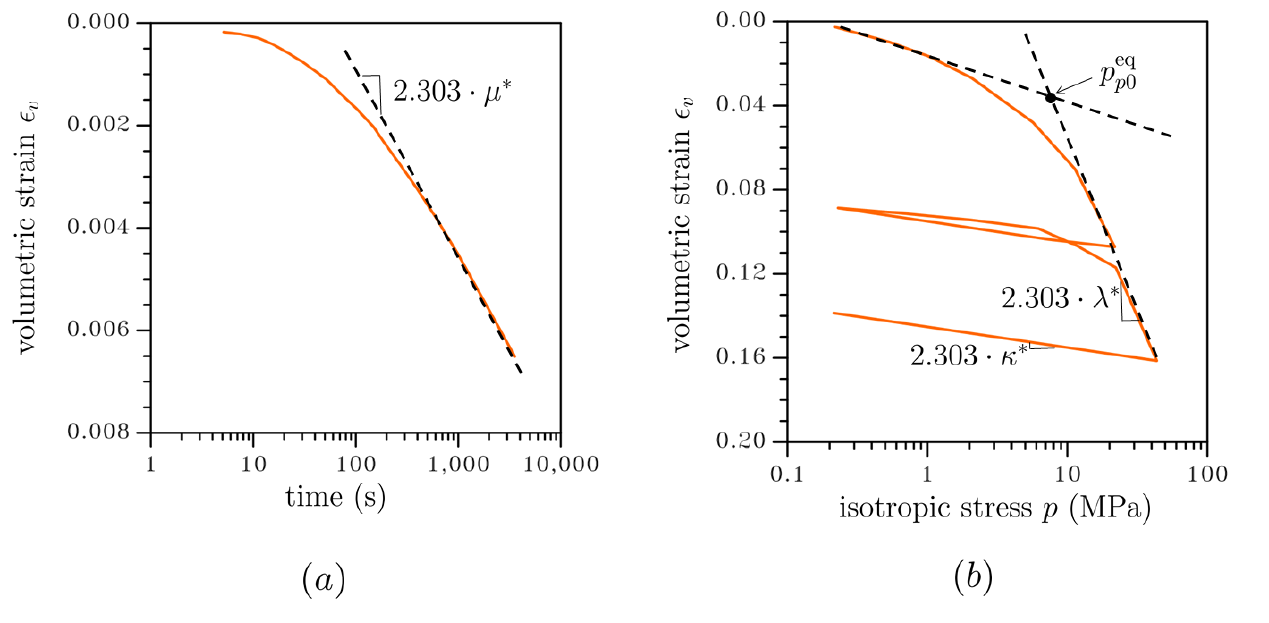
Figure 2. Model parameters from odometric tests: (a) µ ∗ determination; (b) λ ∗ and κ ∗